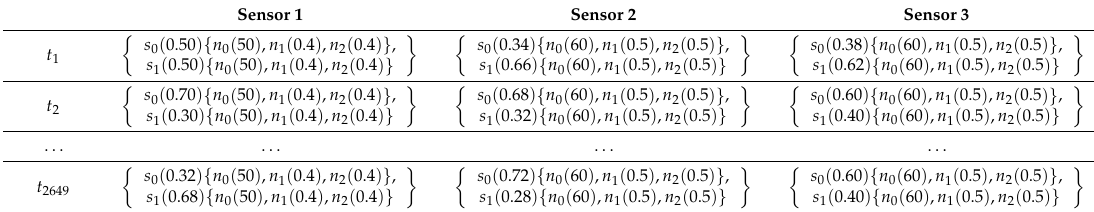
Table 7. Part of the individual overall evaluation vectors.